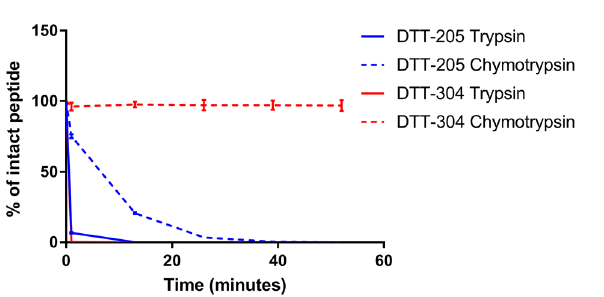
Figure 4. Macroscopic and histological analyses of CT26 and MC38 tumors after treatment with DTT-205 and DTT-304. ( a ) Images of CT26 tumors before treatment, and at day 2 and 10 after three injections with vehicle, 1 mg DTT-205 or 1 mg DTT-304. ( b ) HE staining of whole tumor (scale bar 1000 µm) and enlargement of selected areas of CT26 and MC38 treated with 2 injections of 1 mg DTT-205, DTT-304 or saline. Tumors were harvested 48 h after the first peptide injection.